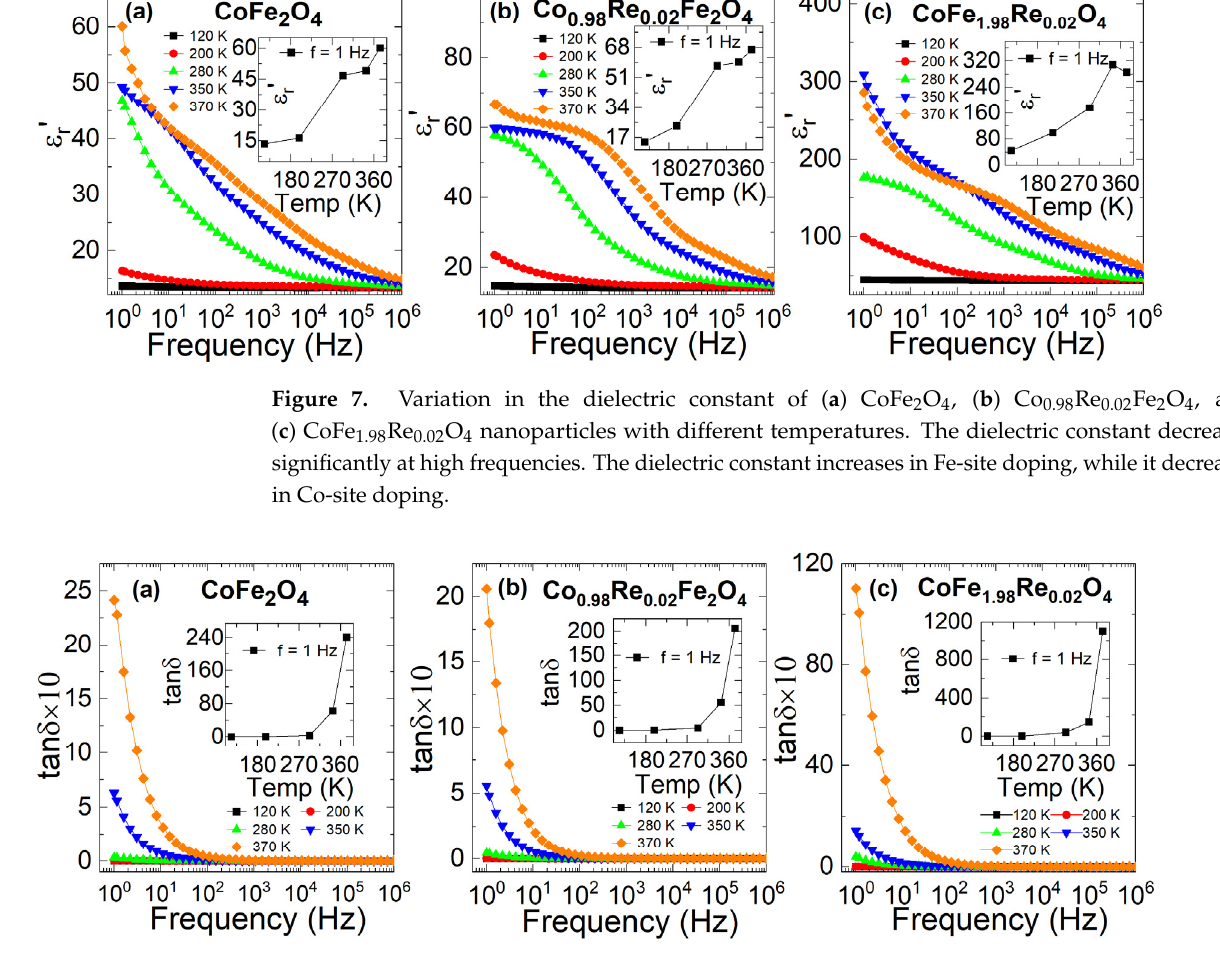
Figure 8. Variation in the energy dissipation of ( a ) CoFe 2 O 4 , ( b ) Co 0 . 98 Re 0 . 02 Fe 2 O 4 , and ( c ) CoFe 1 . 98 Re 0 . 02 O 4 nanoparticles with different temperatures. The energy dissipation decreases at high frequencies. The energy dissipation increases in Fe-site doping, while it decreases in Co-site doping.